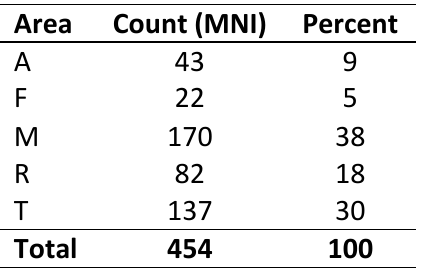
Table 1. Ground stone artifact count (MNI) by excavation area.